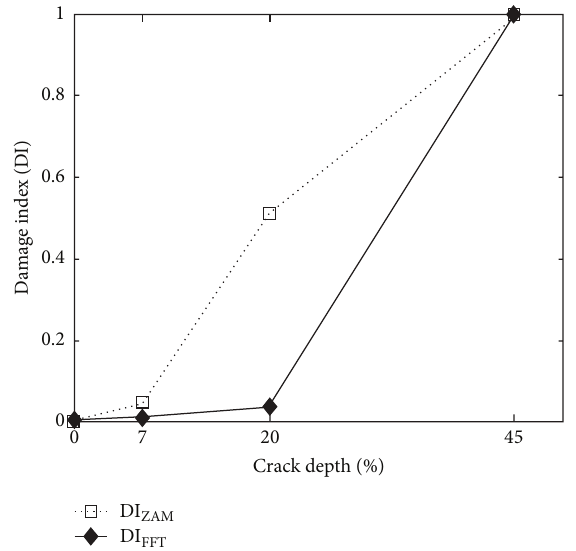
Figure 8: The damage index (DI) derived as the mean value of the sDI for the case of the 1/| ZAM 𝑋 (𝑡,𝑓)| (Figure 7, first row)-DI ZAM and the | FFT (𝑓)| (Figure 7, fourth row)-DI . The increase in the FFT over the DI is sensitivity of the DI ZAM FFT